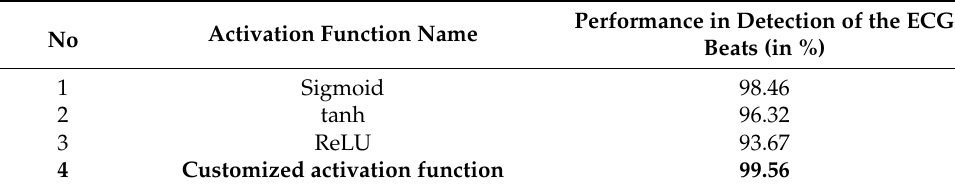
Table 4. The performance of the proposed network with various activation functions.